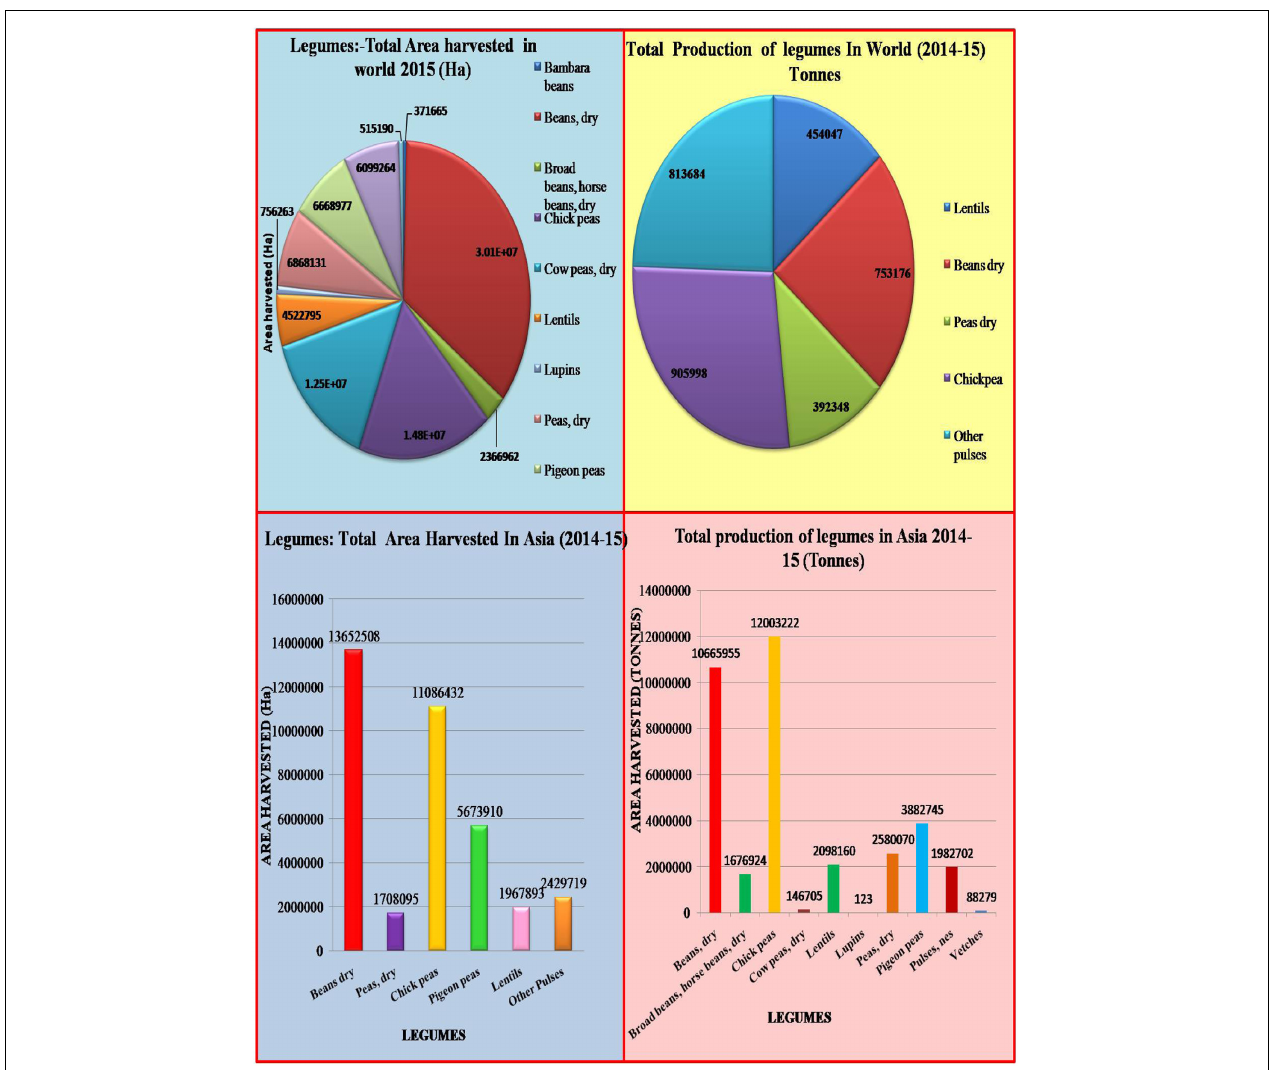
FIGURE 1 | Total legume production and area harvested worldwide an in Asia in 2014–2015 (modified from FAOSTAT,